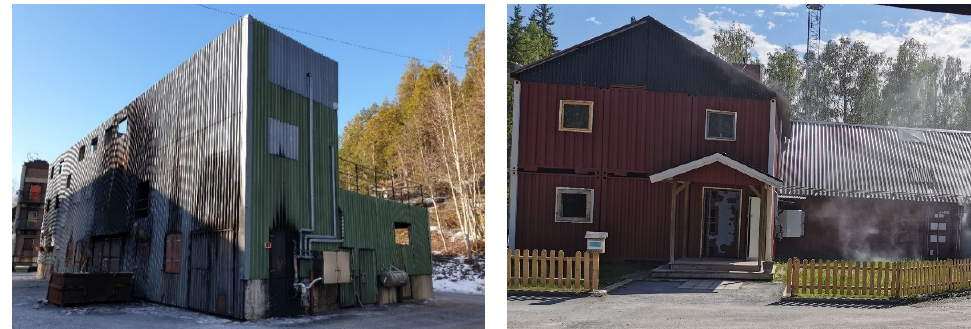
Figure 3. A building ( left ) used for LS, representing, e.g., a four-story apartment building, a me- chanical workshop or a cruise ship, depending on the selected scenario. A family house with an attached garage ( right ), where the fire in the garage can only be represented by generated cold smoke, thus not behaving as a corresponding real fire.